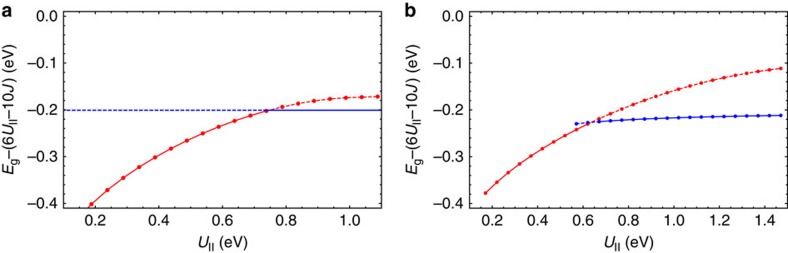
Crossing of the correlated metallic and the band-insulating states.(a) Total energy of the ground electronic phase of A4C60 with cubic band dispersion and suppressed interband electron transfer () as function of U||. The red and the blue lines indicate the correlated band solution (q=0) and band-insulating solution with JT splitting, respectively, and the solid and dashed lines indicate the ground and the excited states, respectively, for each U||. The bielectronic energy (6U||−10J) is subtracted from Eg. (b) The same for the model of A4C60 with full transfer Hamiltonian used in equation (1).